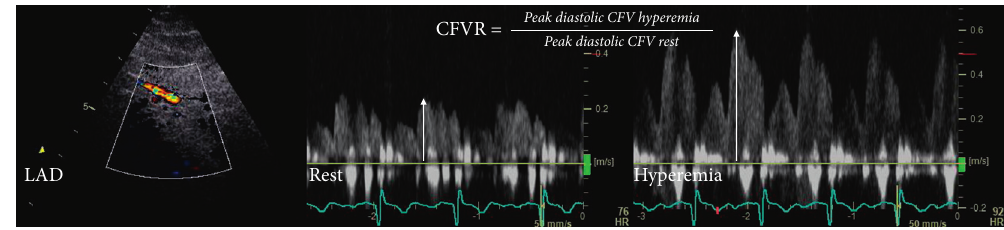
Figure 1: Coronary flow velocity reserve (CFVR) measured in the left anterior descending artery (LAD). Table 1: Noninvasive assessment of coronary microvascular function by transthoracic Doppler echocardiography. Summary of noninvasive assessment of coronary microvascular function by transthoracic Doppler echocardiography Physiological pathway: nonendothelial dependent Preferred coronary artery: left anterior descending artery Measurement: coronary flow velocity reserve (CFVR) ratio of hyperemic to resting coronary flow velocities (m/s); continuous scale Cutoff for coronary microvascular dysfunction: CFR < 2.0